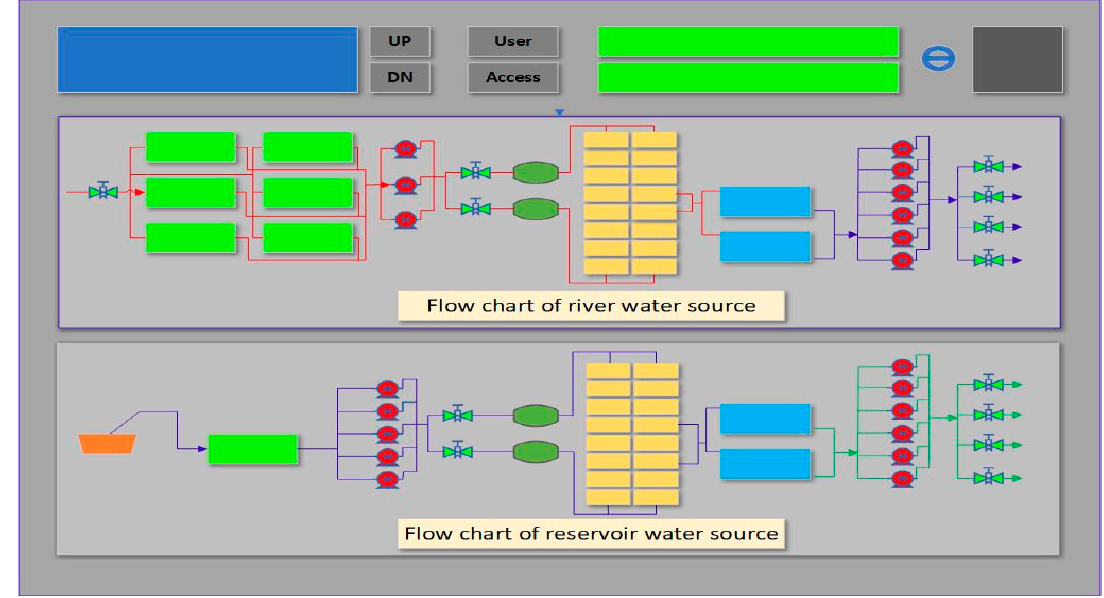
Figure 8. Schematic of real-time monitoring and control system.